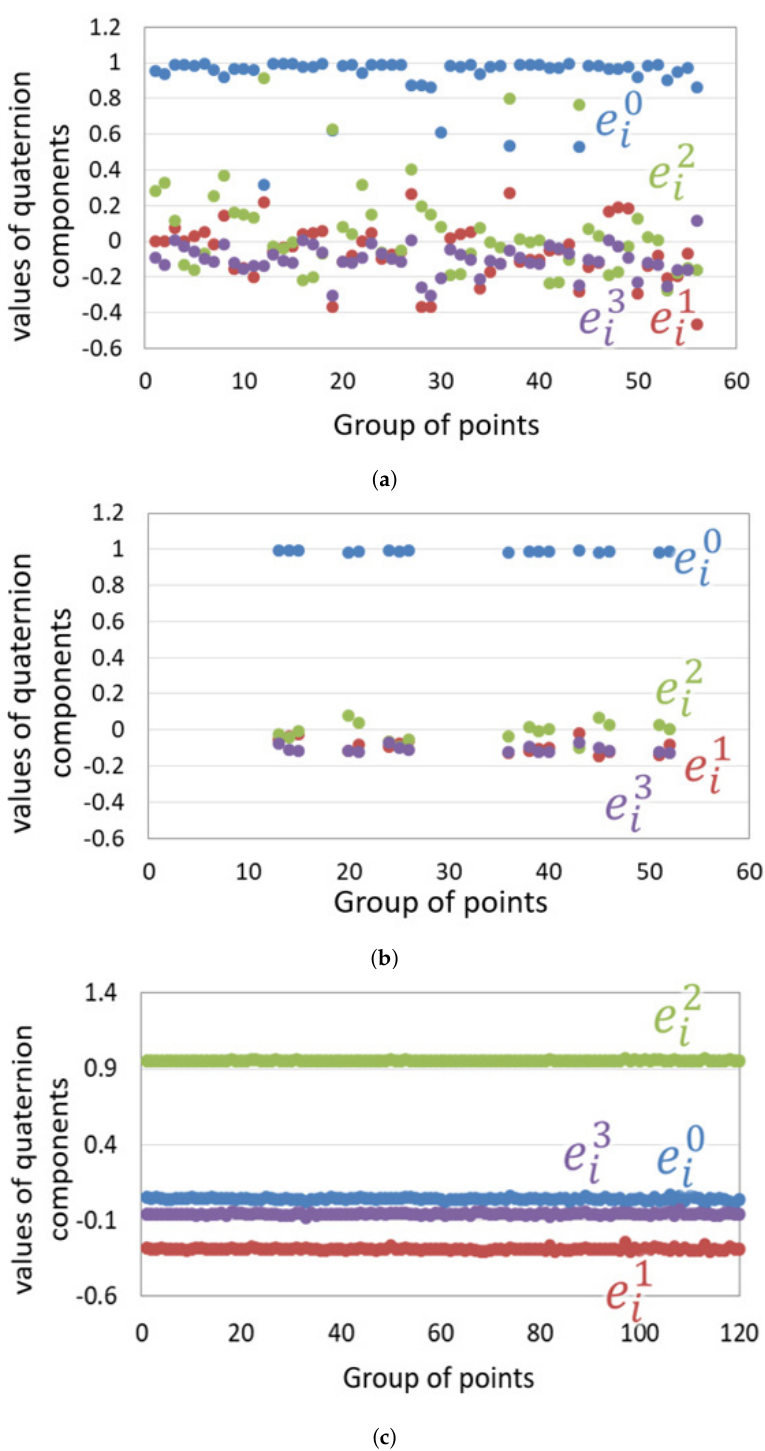
Figure 10. Quaternions calculated using different groups of corresponding vSLAM map points ( a ) without outlier removal, ( b ) after outlier removal and ( c ) ideal set of